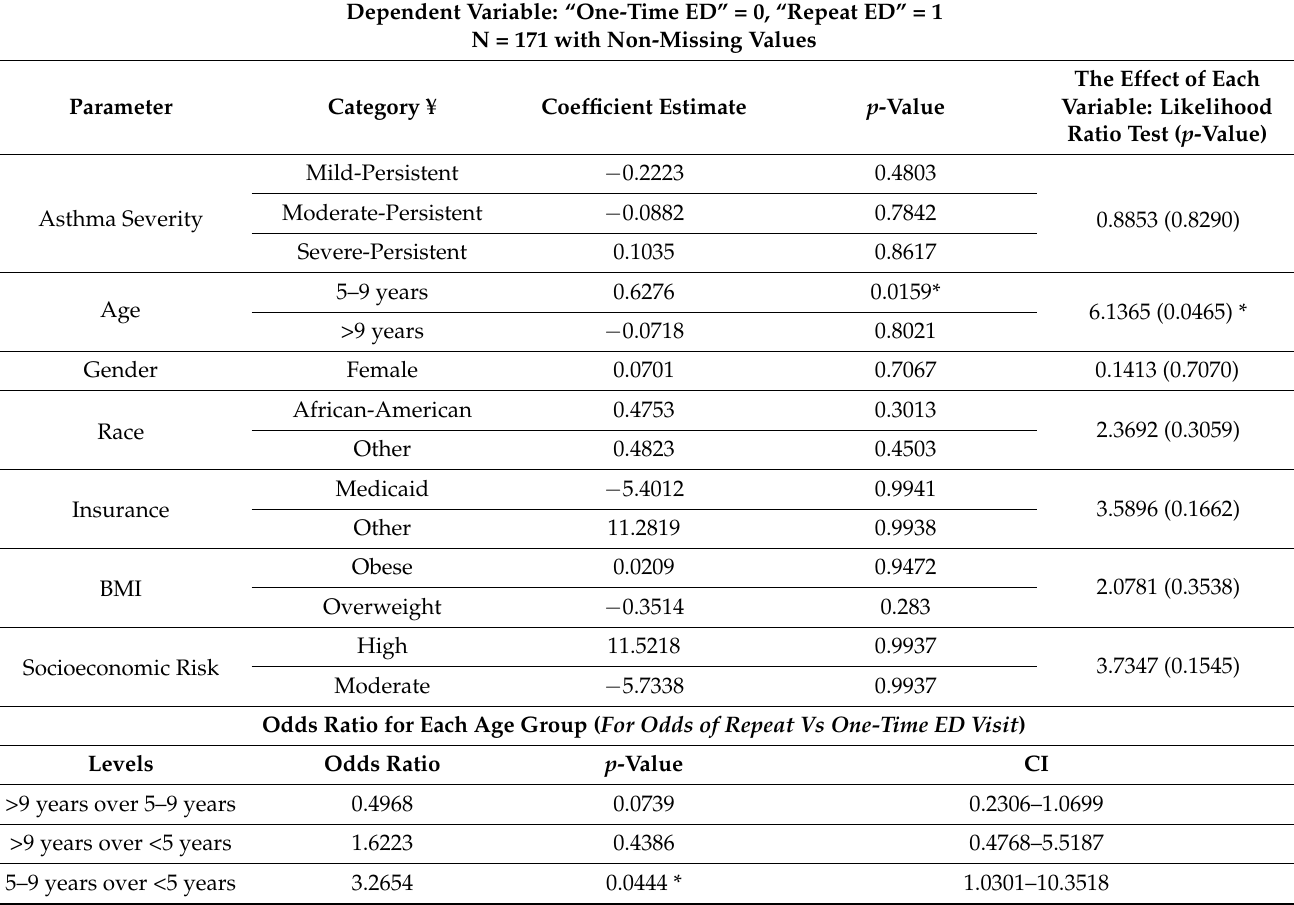
Table 4. Logistic regression analysis (Round 1 analysis: 0–17 years).